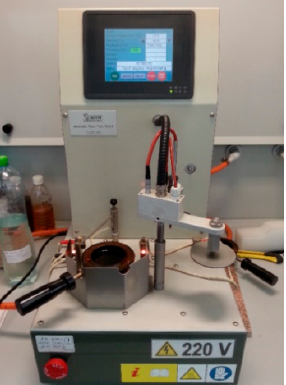
Figure 3. Automatic Flash Point Tester Cleveland.